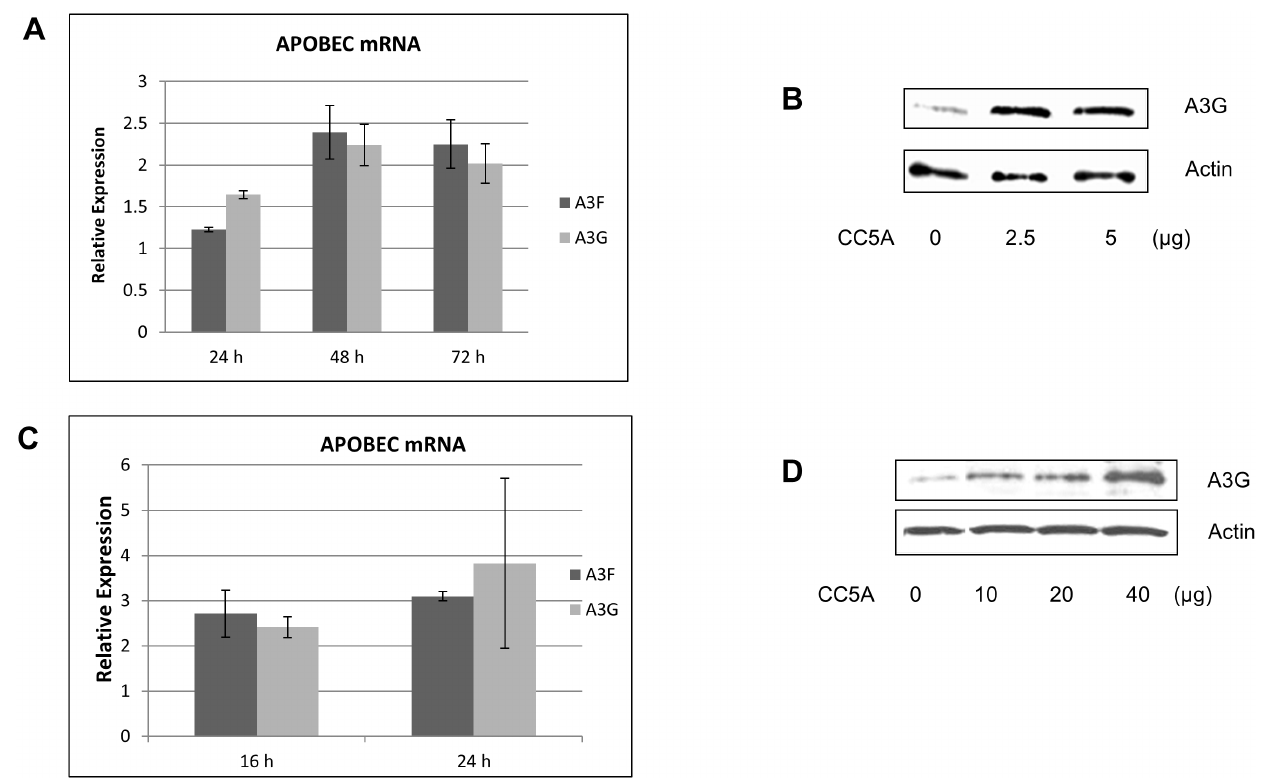
Figure 7. CC5A/PBS induces A3G and A3F expression in human oral keratinocyte (OKF6) and human vaginal VK2 epithelial cells. ( A ) CC5A/PBS (5 m g) was used to treat OKF6 cells. The cells were harvested at the indicated time points, and qRT-PCR was used to measure the relative expression of A3F and A3G mRNA. The expression levels shown represent the ratio of CC5A/PBS treated cells compared to the untreated cells at each given time point. ( B ) Different doses (0–5 m g) of CC5A/PBS were used to treat OKF6 cells for 72 h, and A3G expression was measured by Western-blot analysis. ( C ) VK2 cells were treated with 40 m g CC5A/PBS or vehicle for the time periods shown. qRT-PCR was used to measure the relative expression of A3F and A3G mRNA in these cells. The expression levels shown represent the ratio of the levels found in CC5A/PBS treated cells compared to untreated cells at each time point. ( D ) Different doses (0–40 m g) of CC5A/PBS were used to treat VK2 cells for 48 h. A3G protein expression was measured by Western-blot